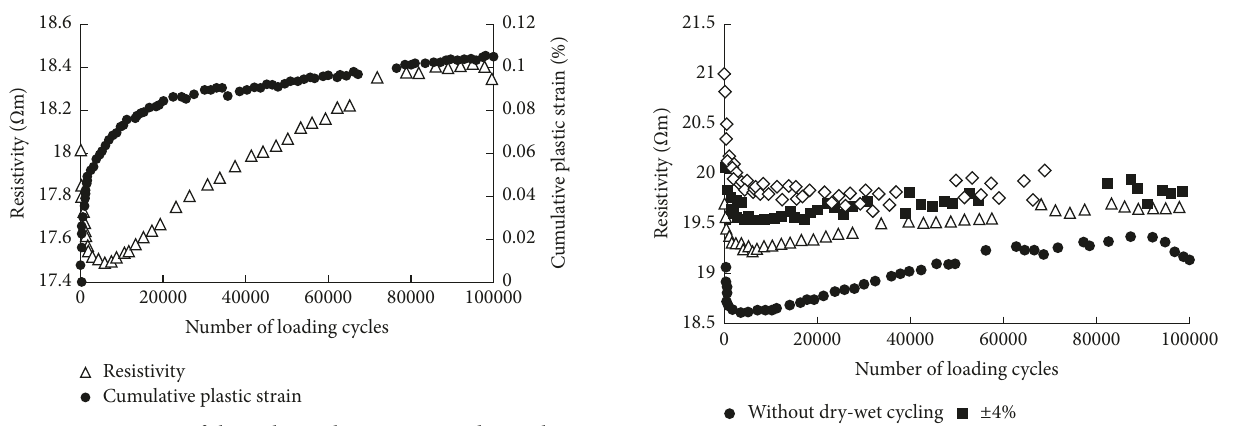
Figure 5: Variations of the soil sample resistivity and cumulative plastic strain with the number of loading cycles.